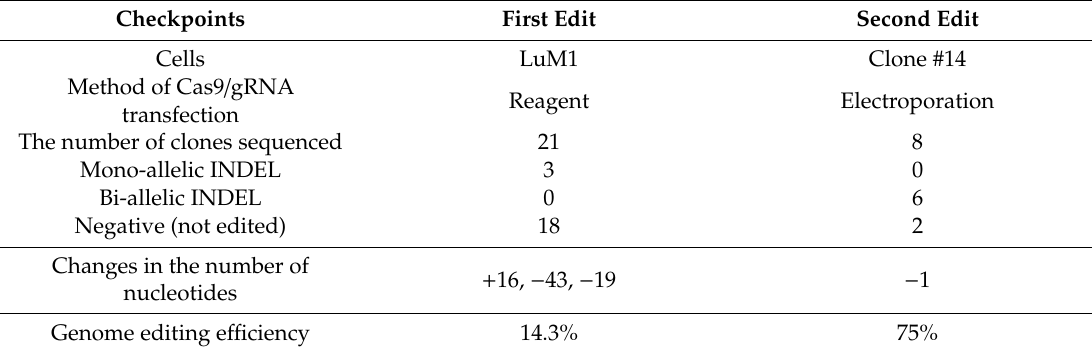
Table 2. Genome editing e ffi